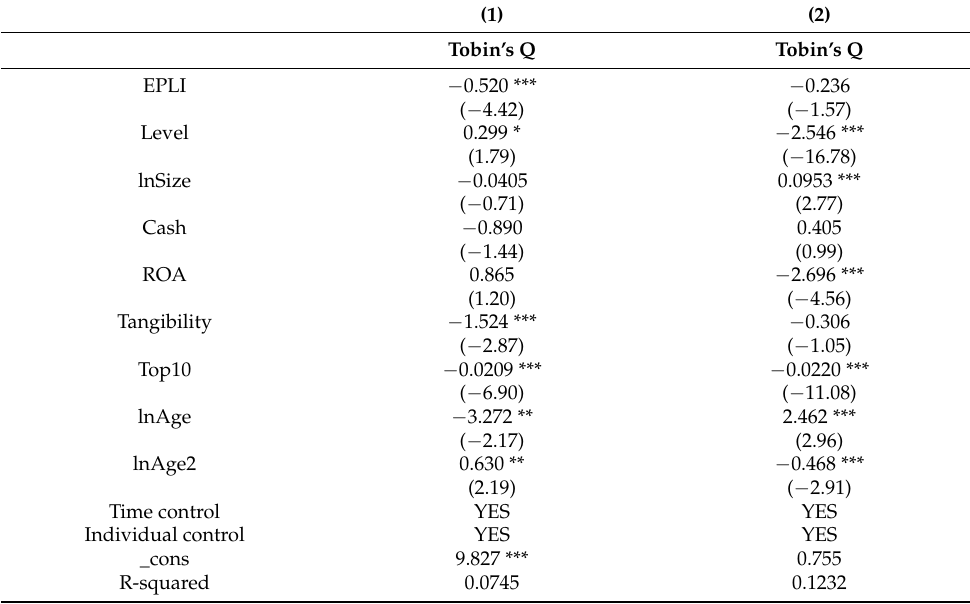
Table 9. Heterogeneity of pollution